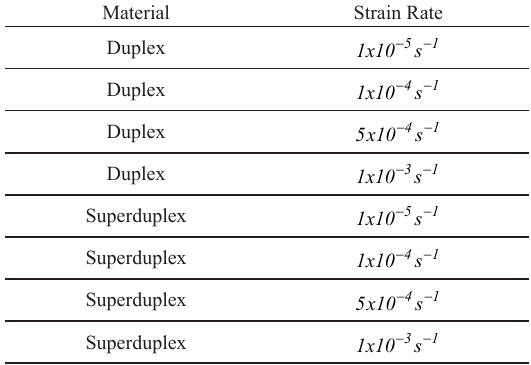
Figure 1. Test specimen dimensions (mm). Table 2. Prescribed strain